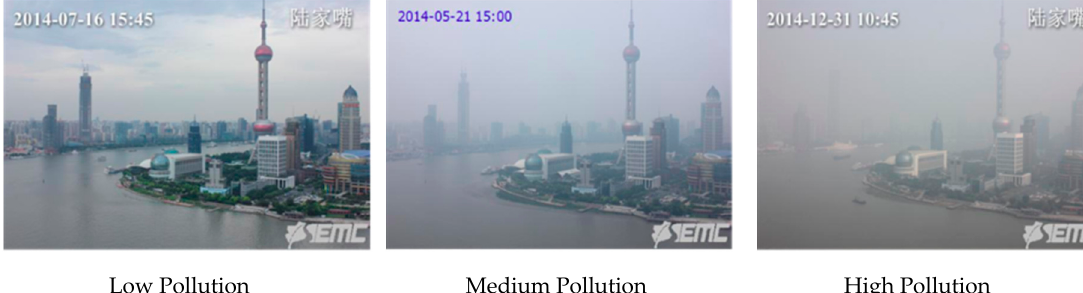
Figure 6. Shanghai Air Pollution images with low, medium, and high levels.